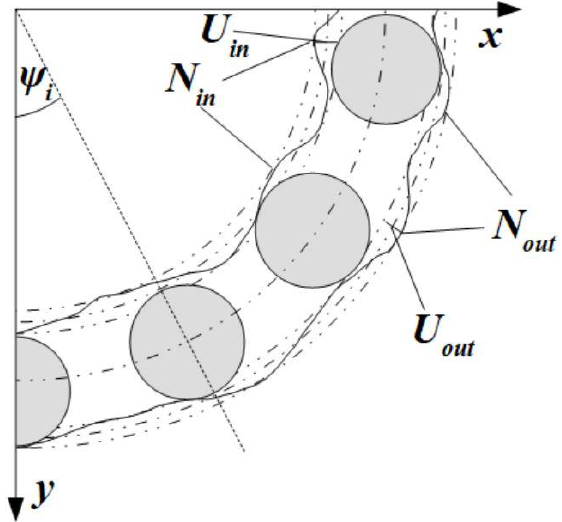
Figure 2. Section of the bearing with marked terms referring to shape errors of the rolling surface U in , U out , N in , N out .